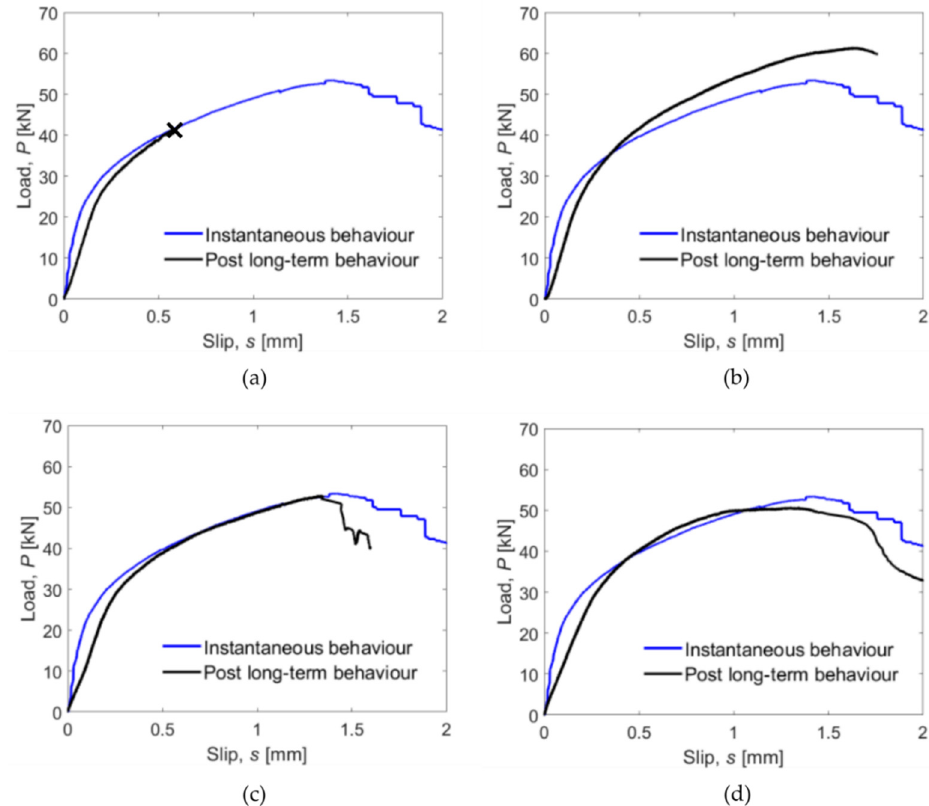
Figure 10. Comparison between the instantaneous behaviour and the post ‐ SL behaviour of the specimen PSL ‐ 225 ‐ 10 ‐ 30 in series ( a ) S1, ( b ) S2, ( c ) S3 ‐ B and ( d ) S4. specimen PSL-225-10-30 in series ( a ) S1, ( b ) S2, ( c ) S3-B and ( d )